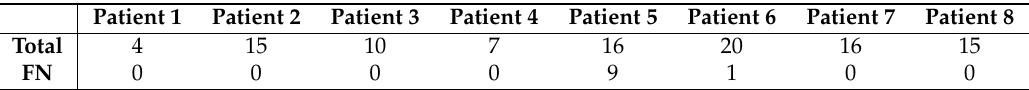
Table 7. Activity recognition for DMD recordings: false negative rates during four-stairs